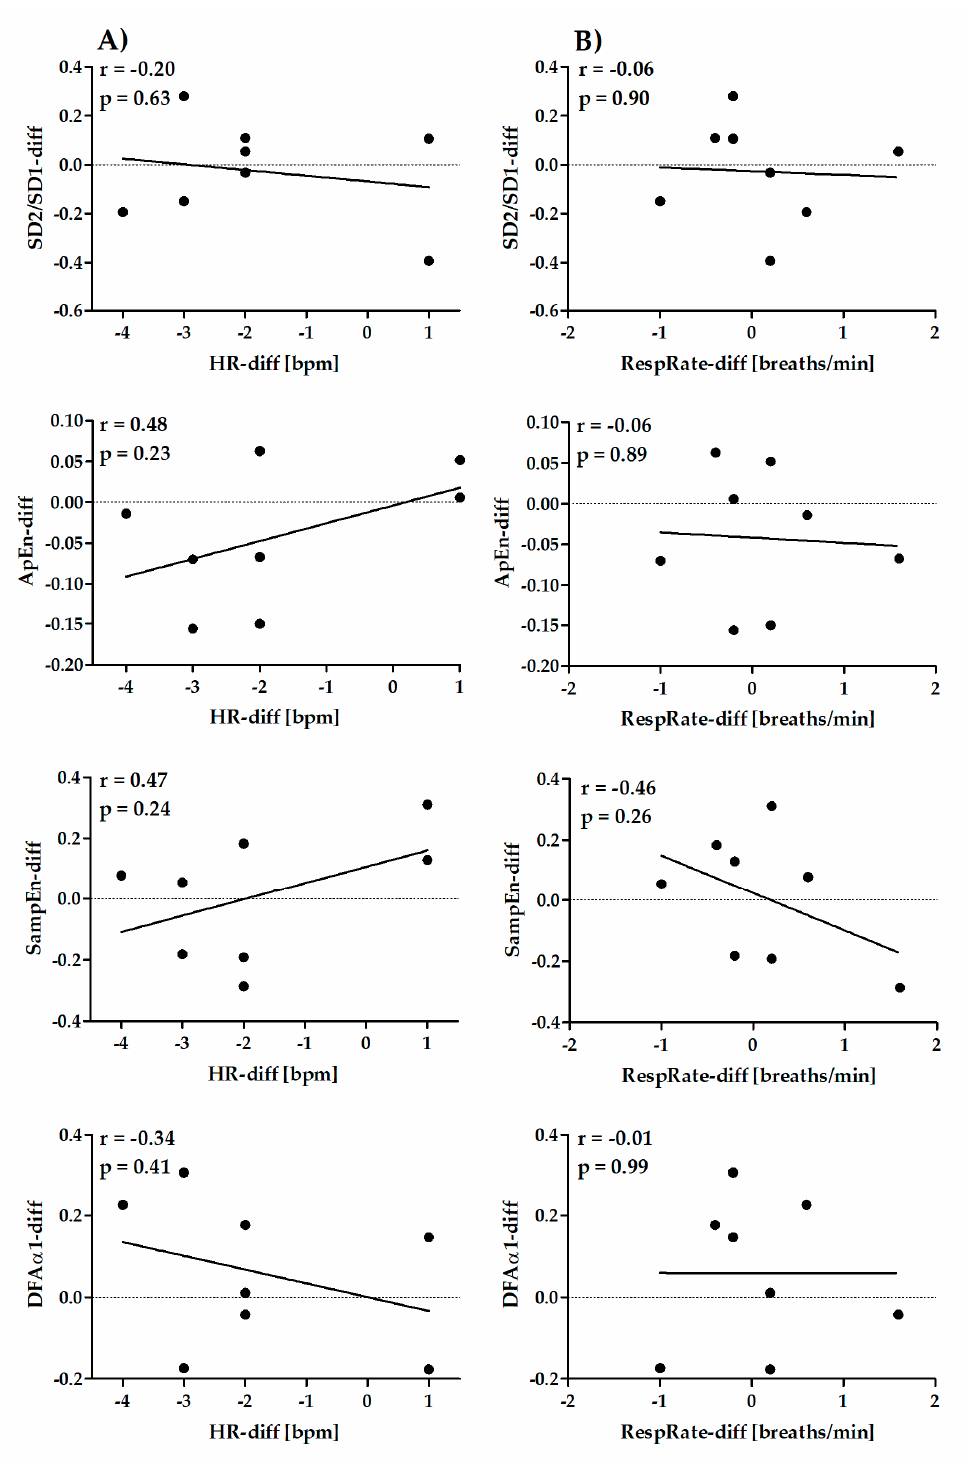
Figure 6. Pearson (cid:48) s correlation coe ffi cient between Retest–Test di ff erences in nonlinear short-term (5 min) HRV indices and di ff erences in HR (HR-di ff ) (column A ) or RespRate (RespRate-di ff ) (column B Figure 6. Pearson ′ s correlation coefficient between Retest–Test differences in nonlinear short-term (5 min) HRV indices and differences in HR (HR-diff) (column A ) or RespRate (RespRate-diff) (column B ).